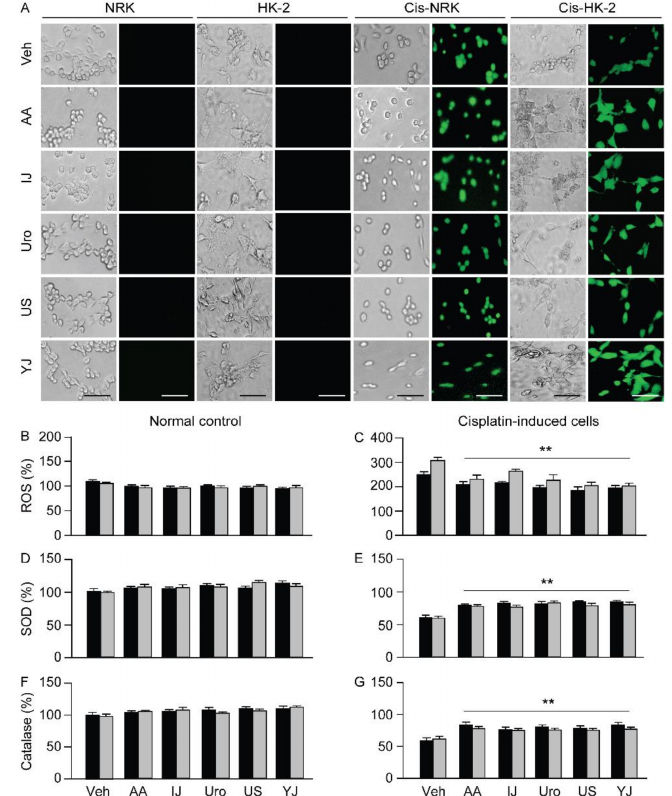
Figure 3. E ff ects on reactive oxygen species production and antioxidant activities. The cisplatin-induced NRK and HK-2 cells (Cis-NRK and Cis-HK-2, respectively) and the corresponding normal controls (NRK and HK-2) were treated with AA, IJ, Uro, US, or YJ for 3 days. Representative images of cells stained with dichlorofluorescein diacetate for reactive oxygen species (ROS) are shown in ( A ). Scale bars indicate 50 µ m. Then, the levels of reactive oxygen species (ROS, ( A – C )) and activities of the superoxide dismutase (SOD, ( D , E )) and catalase ( F , G ) were assessed. Graphs show the results as percentages of the cisplatin-nontreated control. Values are expressed as means ± SD from three independent experiments. **: p < 0.01 versus the cisplatin-treated Veh